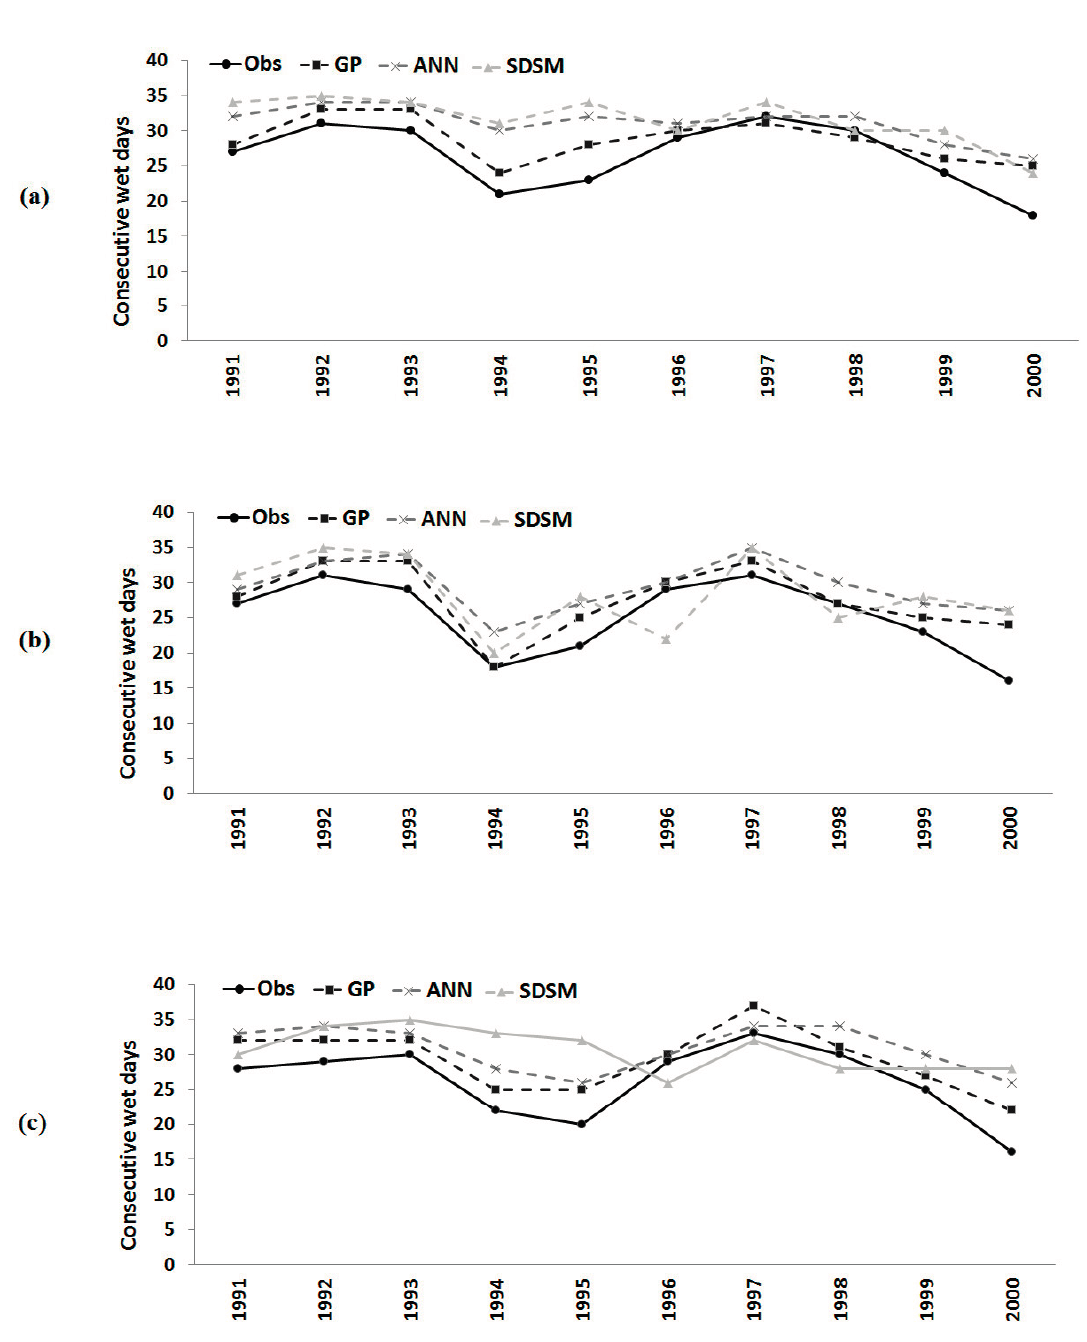
Figure 7. Observed number of consecutive wet days and those downscaled by GP, the ANN and the SDSM during model validation at: ( a ) Besut; ( b ) Dungun; and ( c )